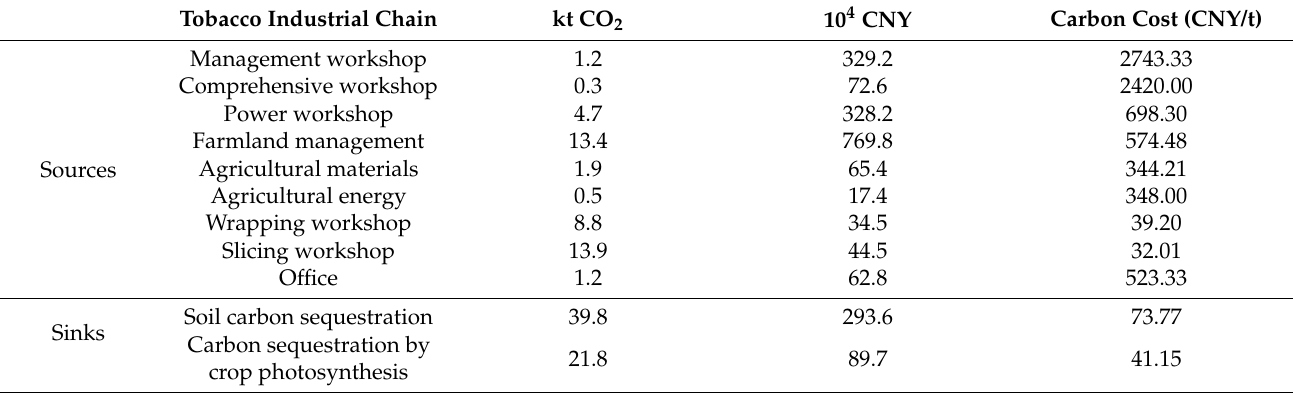
Table 2. Carbon footprint and economic benefits of the tobacco supply